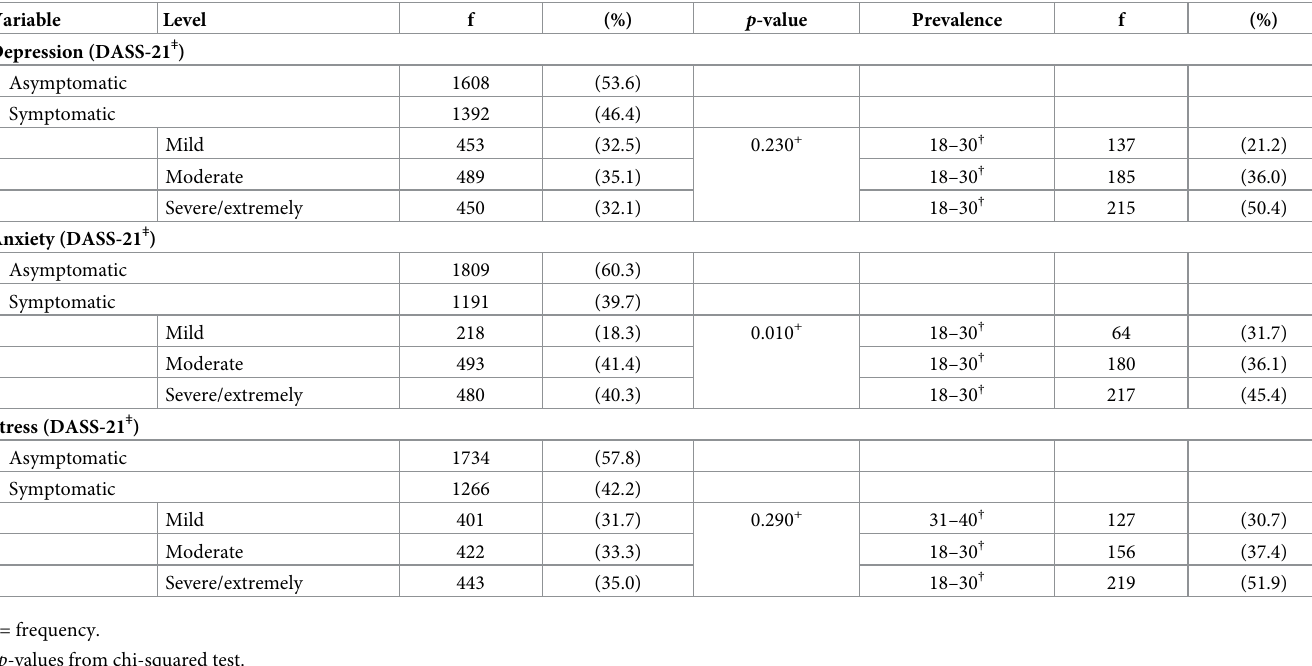
Table 2. Frequency of symptomatic and asymptomatic for depression, anxiety, and stress (N = 3000).